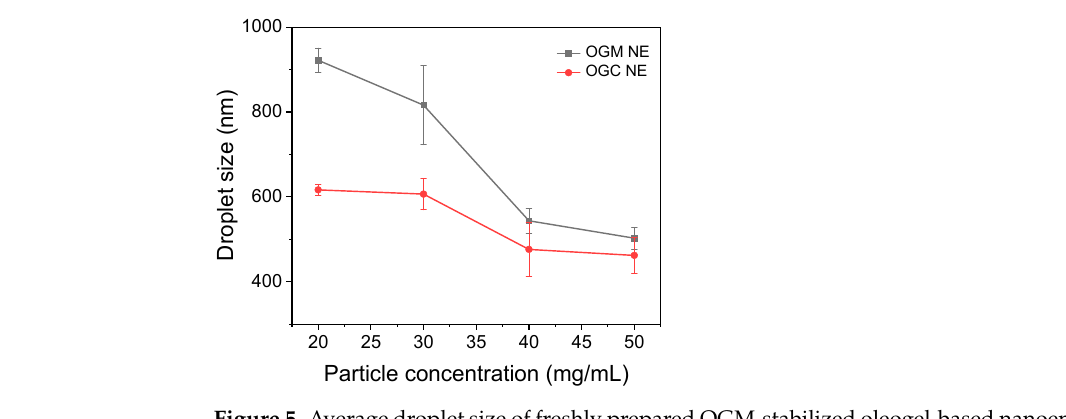
Figure 5. Average droplet size of freshly prepared OGM-stabilized oleogel-based nanoemulsions (NE) and the OGC-stabilized oleogel-based NE (oil fraction ϕ = 0.9) at different particle concentrations (20–50 mg/mL) at room temperature.